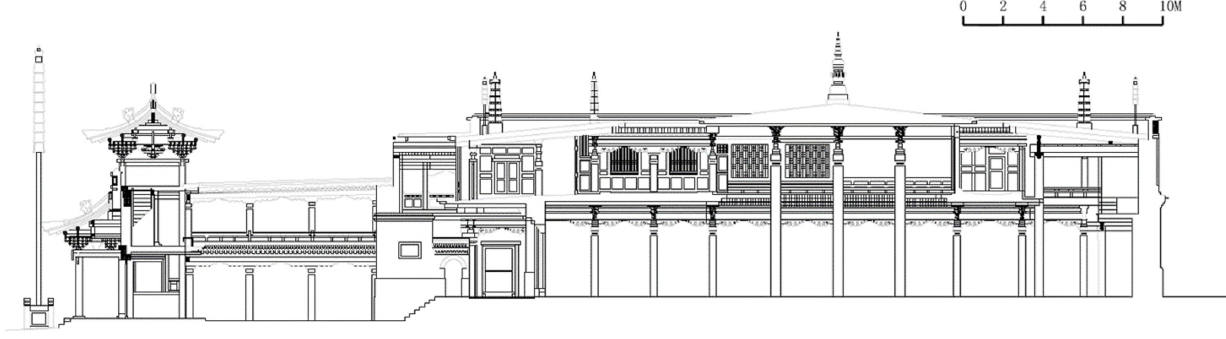
Fig 10. Section of the Great Chanting